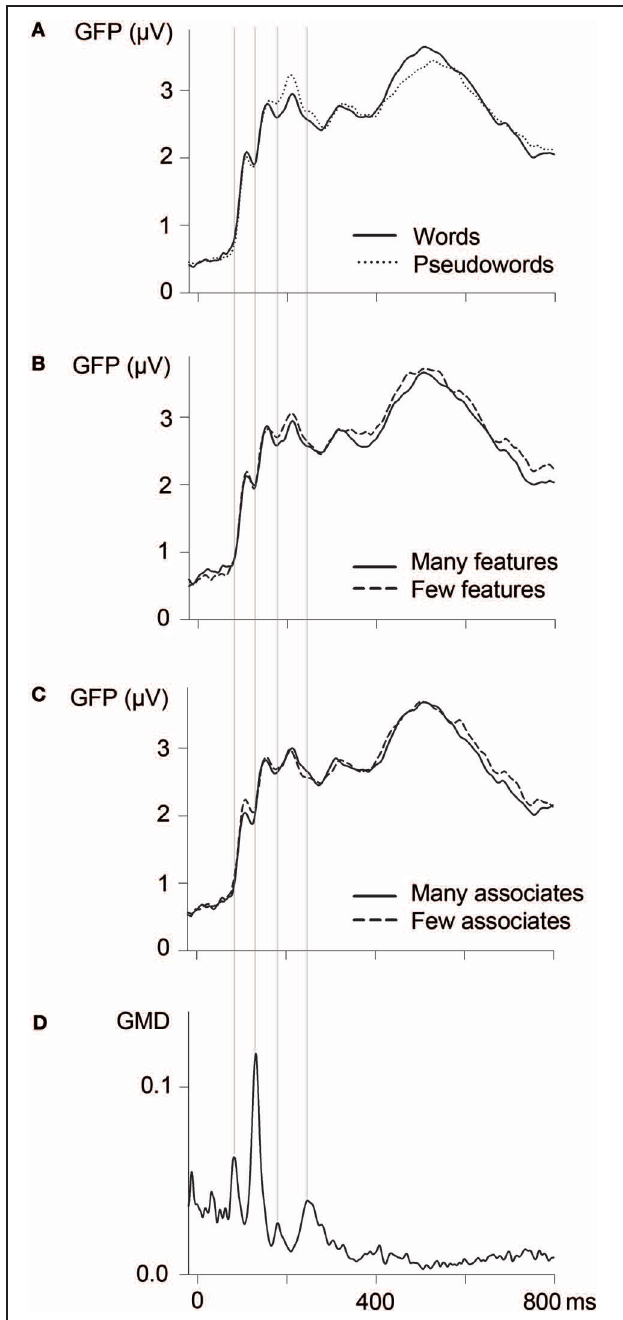
FIGURE 1 | Global field power (GFP; n = 24; 62 channels) as a function of lexicality (A) , the number of semantic features (B) , and the number of associates (C) . Vertical lines indicate borders of ERP segmentation, based on measures of global map dissimilarity (GMD; D ).